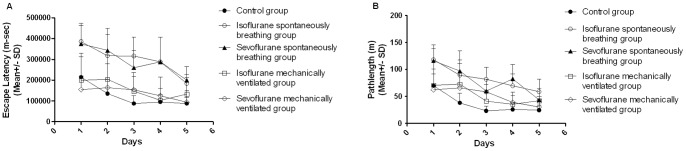
Rats in the spontaneously breathing groups performed worse than other groups when searching platform.Time to reach the platform (escape latency, A) and the distance to reach the platform (pathlength, B) were recorded. Data points represent the average of the sum of four daily trials from four different quadrants for 5-day hidden platform trials. Error bars represent the standard deviation. Although all groups improved over the 5-day trial period, A shows that the rats exposed to 1.7% isoflurane or 2.4% sevoflurane in the chamber took more time to search for the platform than those of the control (p<0.001, repeated-measures ANOVA), but no difference was found among the control and mechanically ventilated groups. Similarly, B shows pathlength was much longer in the spontaneously breathing groups than in the control group (p<0.001, repeated-measure ANOVA). No significant difference was observed among the control and mechanically ventilated groups. (p>0.05).